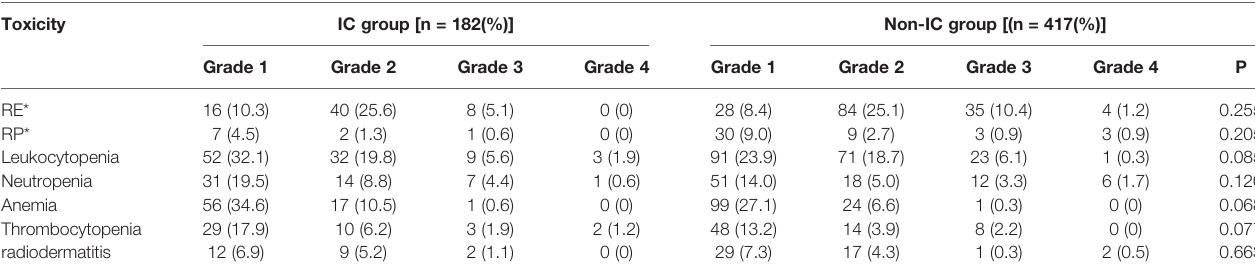
TABLE 2 | Comparison of toxicities between the two groups. Toxicity IC group [n =